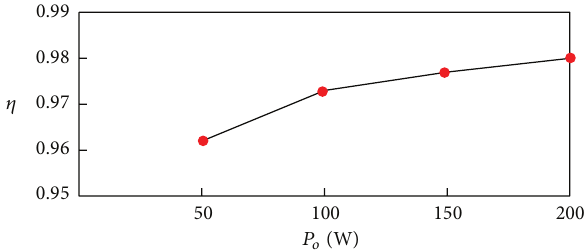
Figure 9: Efficiency of the converter with 100V DC output voltage.